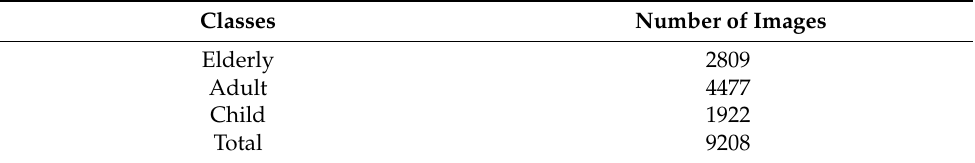
Table 1. The dataset information about the total number of images for each class.